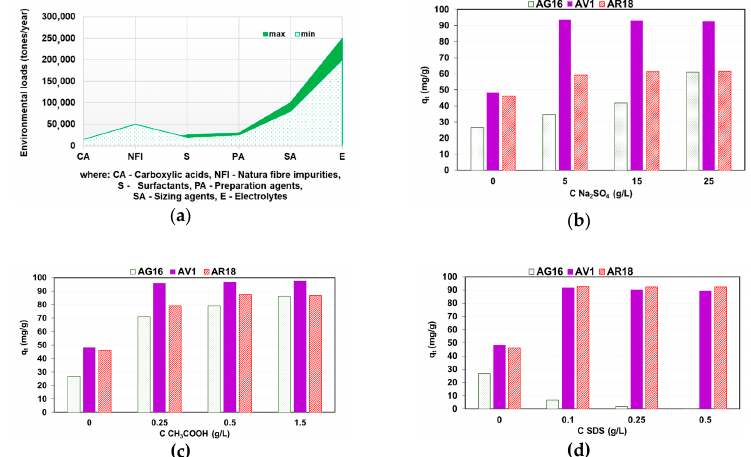
Figure 8. Environmental loads of auxiliaries in European countries ( a ) [10] and impact of Na 2 SO 4 ( b ), CH 3 COOH ( c ) and anionic surfactant SDS ( d ) on AV1, AG16 and AR18 (C 0 = 100 mg / L) sorption on DVB- co -GMA-TETA.